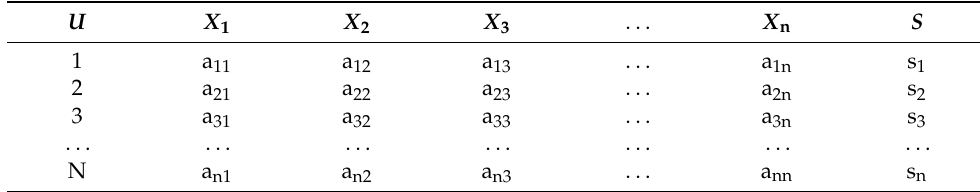
Table 2. Strategy